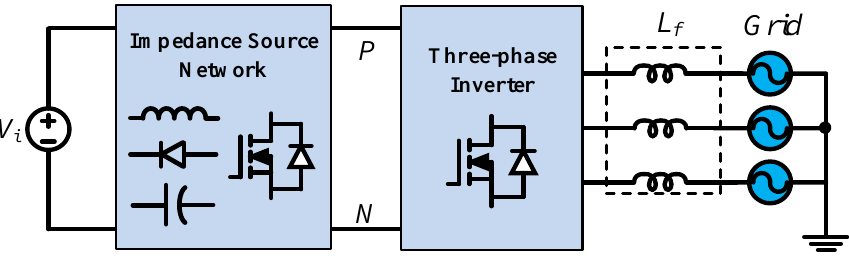
Figure 7. General structure of impedance-source-networks-based three-phase transformerless VSI.